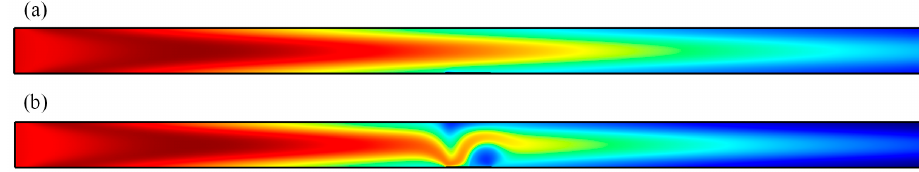
Figure 10. Concentration distribution of ICEO modified channel flow at t = 17 s when the driving electrode pair was energized with voltage signals of ( a ) 0 V; and ( b ) 8 V. Here, the red, blue, and green colors represent the different rates of binding concentration to initial concentration, namely, 1, 0.5, and 0, respectively.